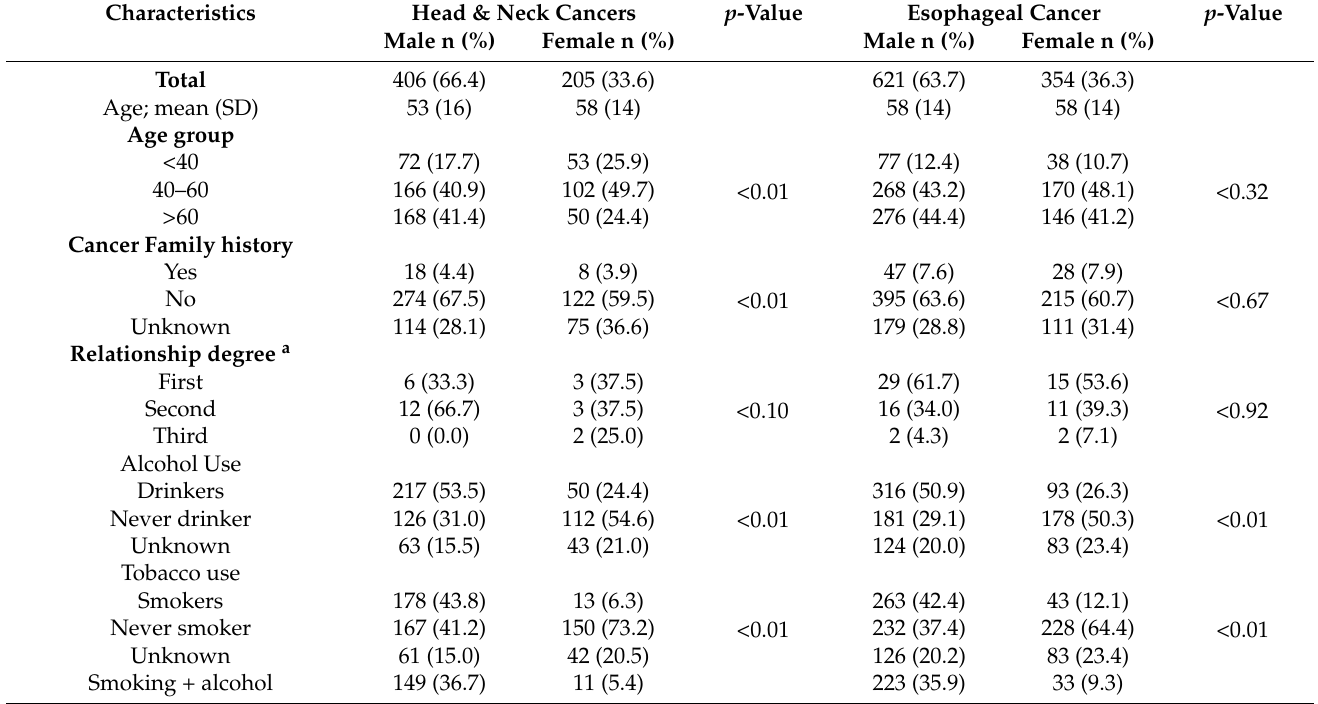
Table 1. Socio-demographic characteristics among head and neck and esophageal cancers patients at the cancer hospital in Tanzania 2019–2021. Men and women are compared using chi-square